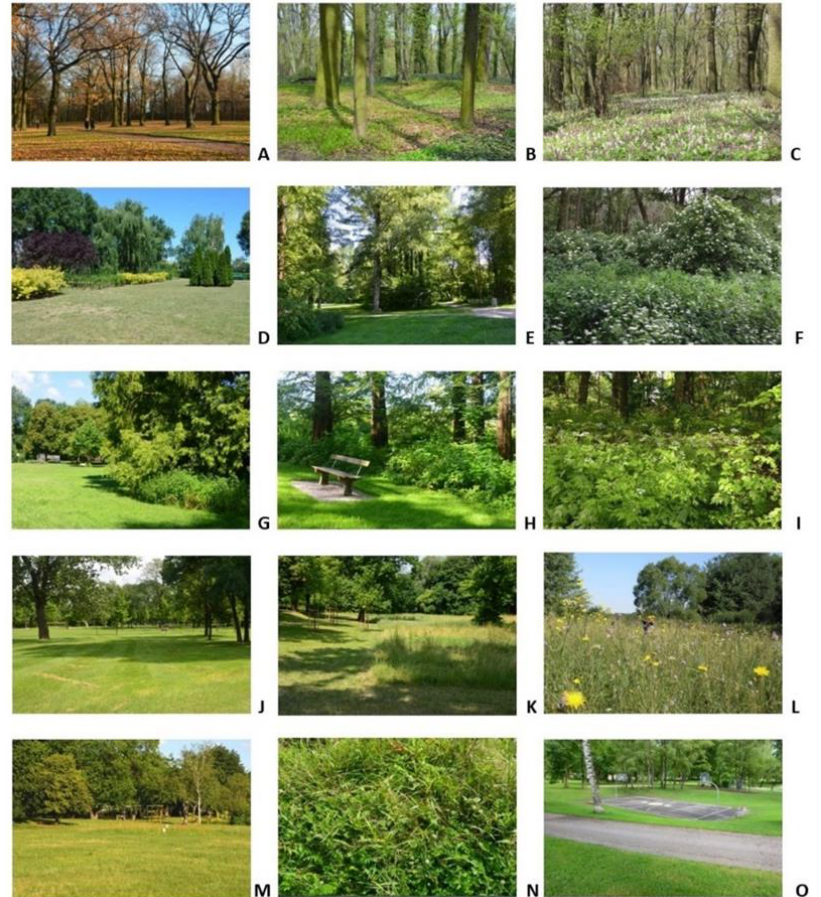
Figure 1. Elements of the proposed vegetation cover pattern of urban park restoring and enhancing the biodiversity. ( A – C )—clusters of tall trees with: mowed herb layer ( A ), unmoved planted ground cover vegetation ( B ), a physiognomy reminiscent of natural forest ( C ); ( F , I , L , O )—the sequence of vegetation formations: tall-tree cluster, thicket, tall-herb fringe community, flower meadow, lawn; ( D – F ) — shrub formations: clumps of ornamental shrubs with spontaneous weed vascular flora ( D ), shrubs spontaneously developed in clumps of ornamental trees ( E ), natural thicket and tall herb fringe community in the ecotone ( F ); ( G – I ) — tall herb fringe communities: spontaneously developed in the ornamental tall tree clusters’ ecotone in the active ( G ) and passive ( H ) recreation zones, natural tall-herb fringe community in the ecotone ( I ); ( J – O ) — grasslands: highly manicured lawn in the passive ( J ) and active ( M ) recreation zones, a piece of lawn that is mowed less frequently ( K , on the right), lawn converted into a hay seminatural flower meadow ( L ), floristic composition of lawn carpet from phot. ( M , N ), highly manicured ornamental carpet in the active recreational zone, care treatment similar to that in the agricultural landscape ( O ).